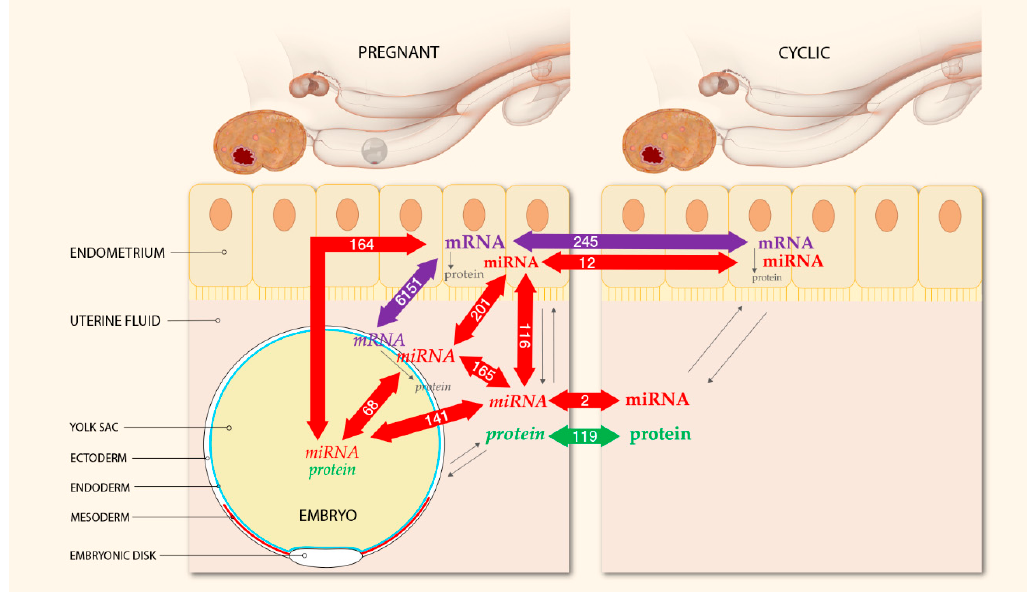
Figure 1. Experimental design and numbers of differentially expressed mRNAs, miRNAs and proteins detected at the embryo–maternal interface 13 days after ovulation in the horse. Micro-RNA-sequencing was performed of the uterine tissue and fluid of pregnant and cyclic mares and of the corresponding embryonic tissue and YS fluid. Messenger-RNA-Sequencing was conducted on the endometrium and the embryonic tissue of pregnant and cyclic mares, and proteomics of UF and YS fluid was reported previously [26]. All molecules originating from the embryo are displayed in Italics , and molecules of maternal origin are in bold . Colored arrows indicate the number of differentially expressed molecules in each comparison. Biological interactions are shown by black arrows; in all tissues mRNAs are translated into proteins and this interaction is influenced by miRNAs; molecules of both embryonic and maternal origin can be secreted into the UF and play a role in the embryo–maternal dialogue.